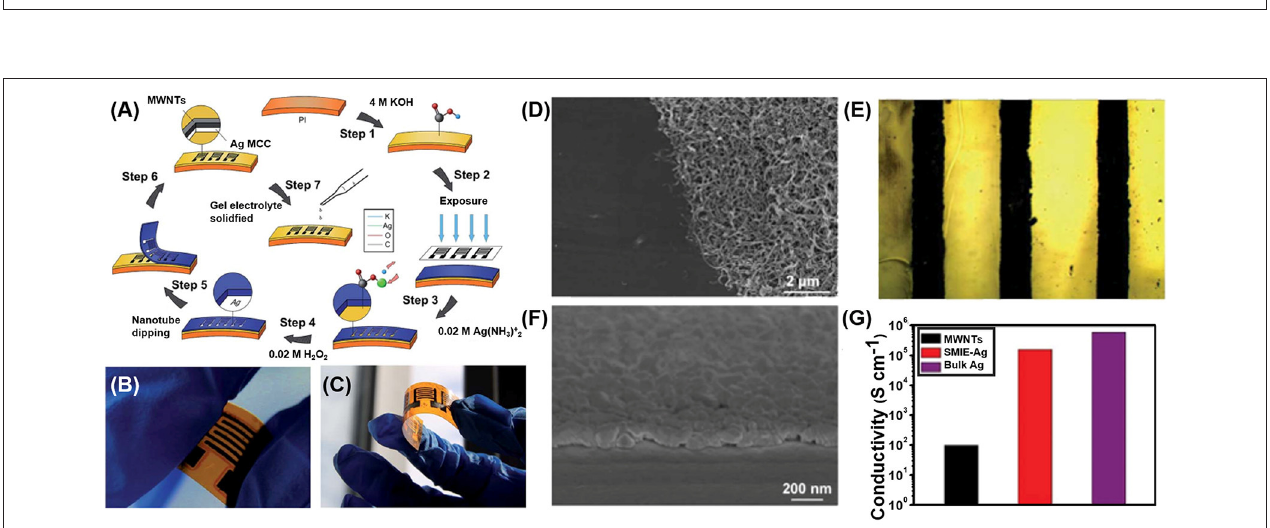
FIGURE 12 | (A) A flow chart of micro-supercapacitors using surface metallization via the ion-exchange method. (B,C) Optical images of supercapacitors with printed electrodes. (D) SEM image of the boundary of the substrate and electrode. (E) The optical image of electrodes of multiwall carbon nanotubes. (F) SEM image of metal current collector. (G) Conductivity comparison among various materials as electrodes (Yu et al., 2015b). Reproduced with the permission of 2015 Royal Society of Chemistry.